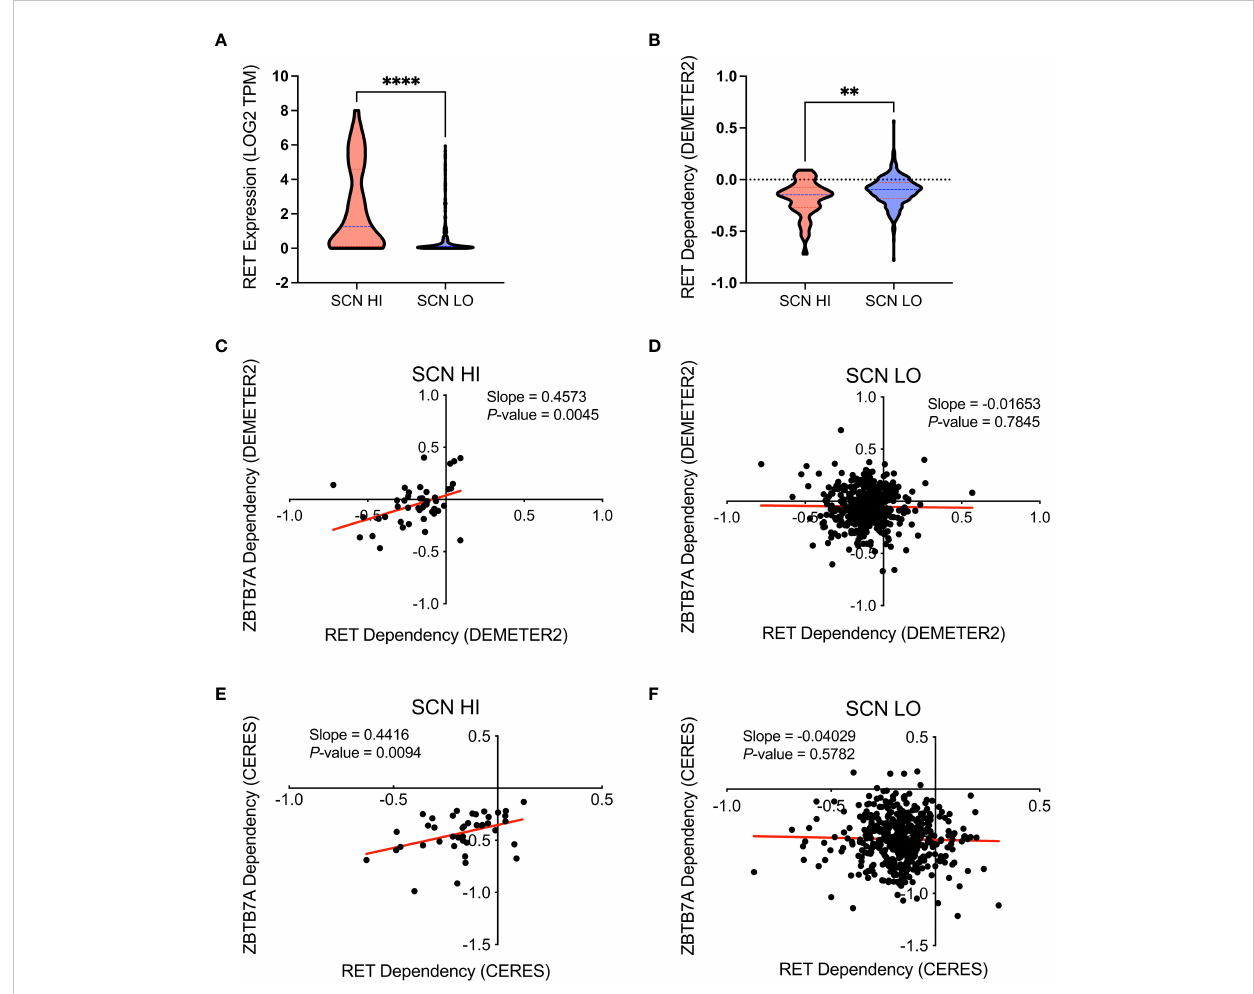
FIGURE 1 Functional co-dependency analyses identi fi ed small-cell neuroendocrine cancer cell lines to be dependent on RET and ZBTB7A. (A) Comparison of RET mRNA expression between cancer cell lines with SCN score ≥ 1.1 (SCN HI) and SCN score< 1.1 (SCN LO). RET mRNA expression values were obtained from Cancer Cell Line Encyclopedia Cancer. **** p <0.0001 by Mann-Whitney test. (B) Comparison of relative RET dependency scores (DEMETER2) between SCN HI and SCN LO cell lines. DEMETER2 scores taken from DepMap (DEMETER2 Data v6) re fl ect the impact of shRNA mediated RET knockdown on cell proliferation and the lower score indicates greater dependency on RET. ** p <0.01 by Mann-Whitney test. (C, D) RET DEMETER2 scores of SCN HI (C) and SCN LO (D) cell lines were plotted against ZBTB7A DEMETER2 scores. (E, F) RET CERES scores of SCN HI (E) and SCN LO (F) were plotted against ZBTB7A CERES scores. CERES scores (DepMap Public 20Q4 v2) indicate the relative effect of gene perturbation by CRISPR/Cas9 on cell proliferation. (C-F) Each dot represents a cell line and the linear regression lines are in